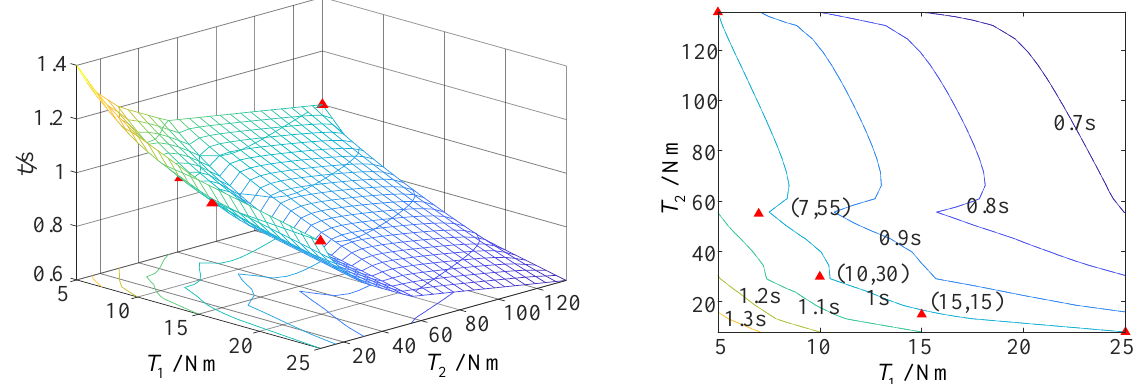
Figure 17. The curve of driving torque and deployment time of folding wing at an airspeed of 20 m/s (non-fixed-axis – fixed-axis stepwise deployment mode). When the non-fixed-axis – fixed-axis stepwise deployment mode is adopted and the airspeed is 30 m/s, the minimum driving torque required by axis 1 to complete the action is 15 Nm, and that required by axis 2 to complete the action is 15 Nm, on the premise that the folding wing can complete the action within 1 s, as shown in Figure 18.